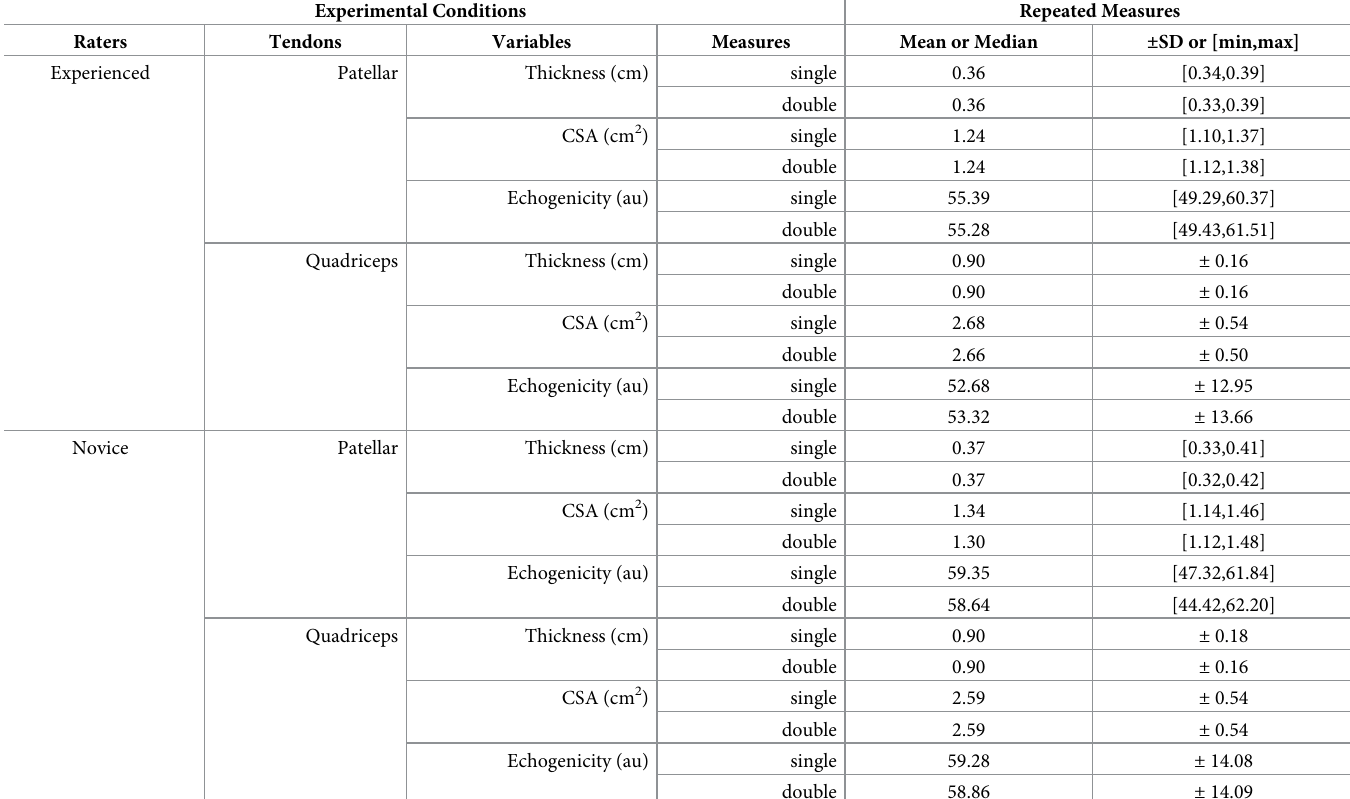
Table 1. Measurement behaviour recorded in each of the 24 experimental conditions.